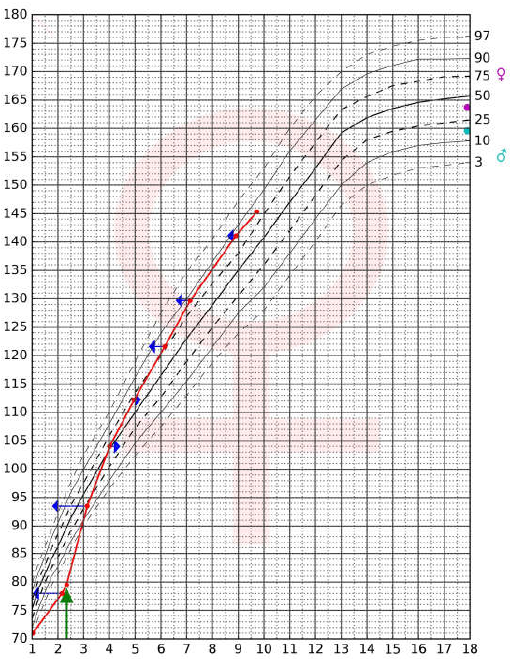
Figure 2. Growth curve of Patient 2 before and during rhGH therapy. Patient’s growth curve on the centile chart for girls of Palczewska and Niedźwiecka [10]: horizontal axis—patient’s age (years), vertical axis—patient’s height (cm); dark blue arrows—bone age of the girl at particular time points, assessed according to Greulich-Pyle standards [12]; green arrow—rhGH therapy onset; pink dot—mother’s height, blue dot—father’s height SDS transposed into a centile chart for girls.